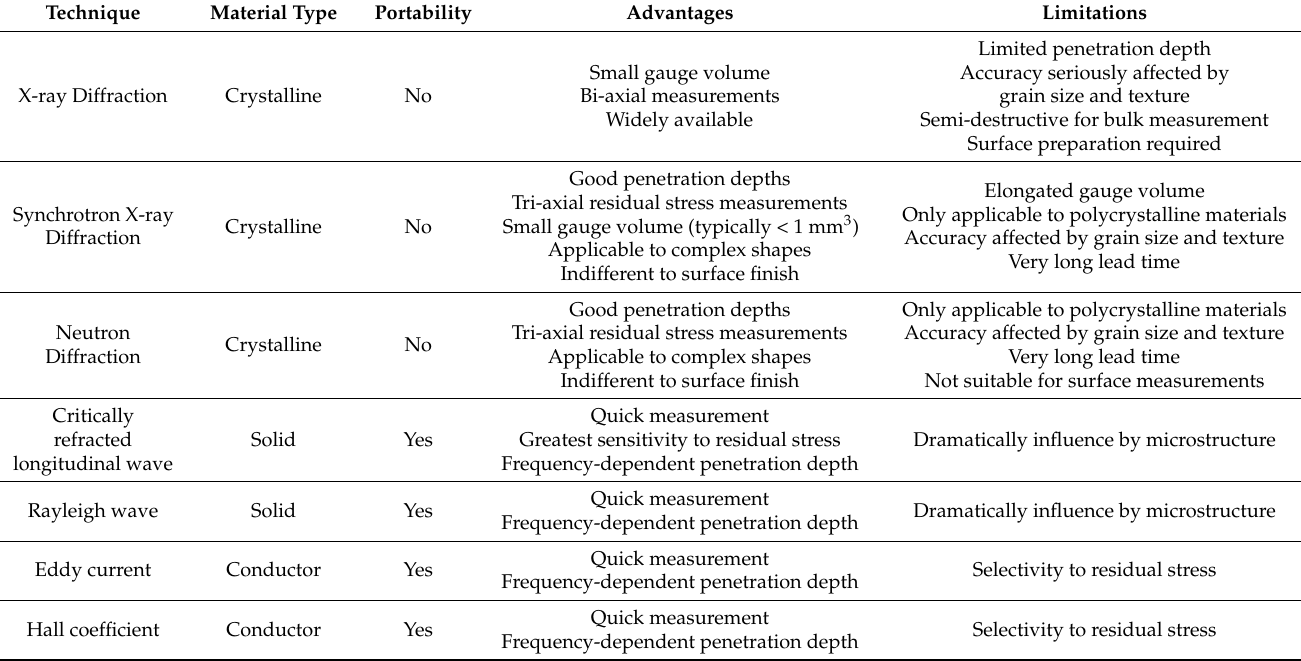
Table 1. Comparisons of the non-destructive residual stress profiling